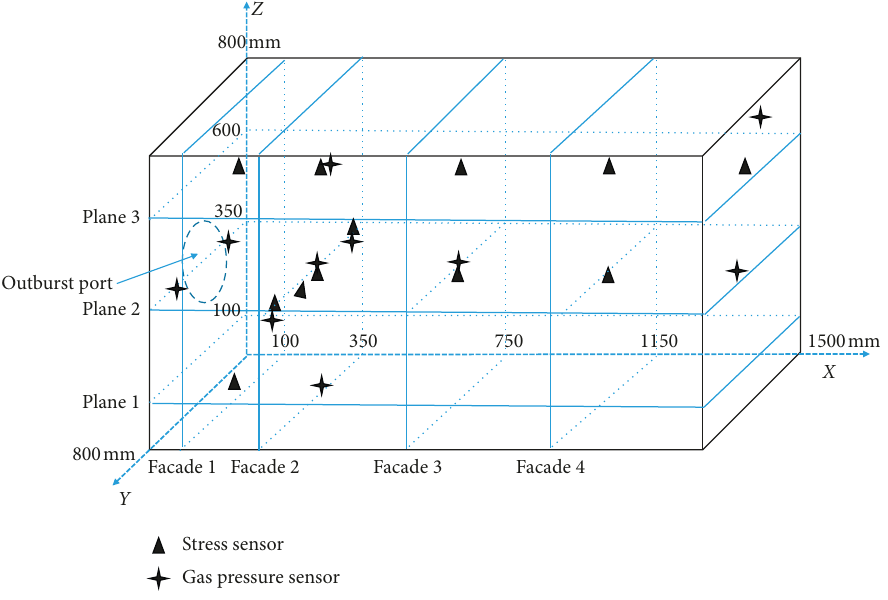
Figure 4: Sensors arrangement in the sealing